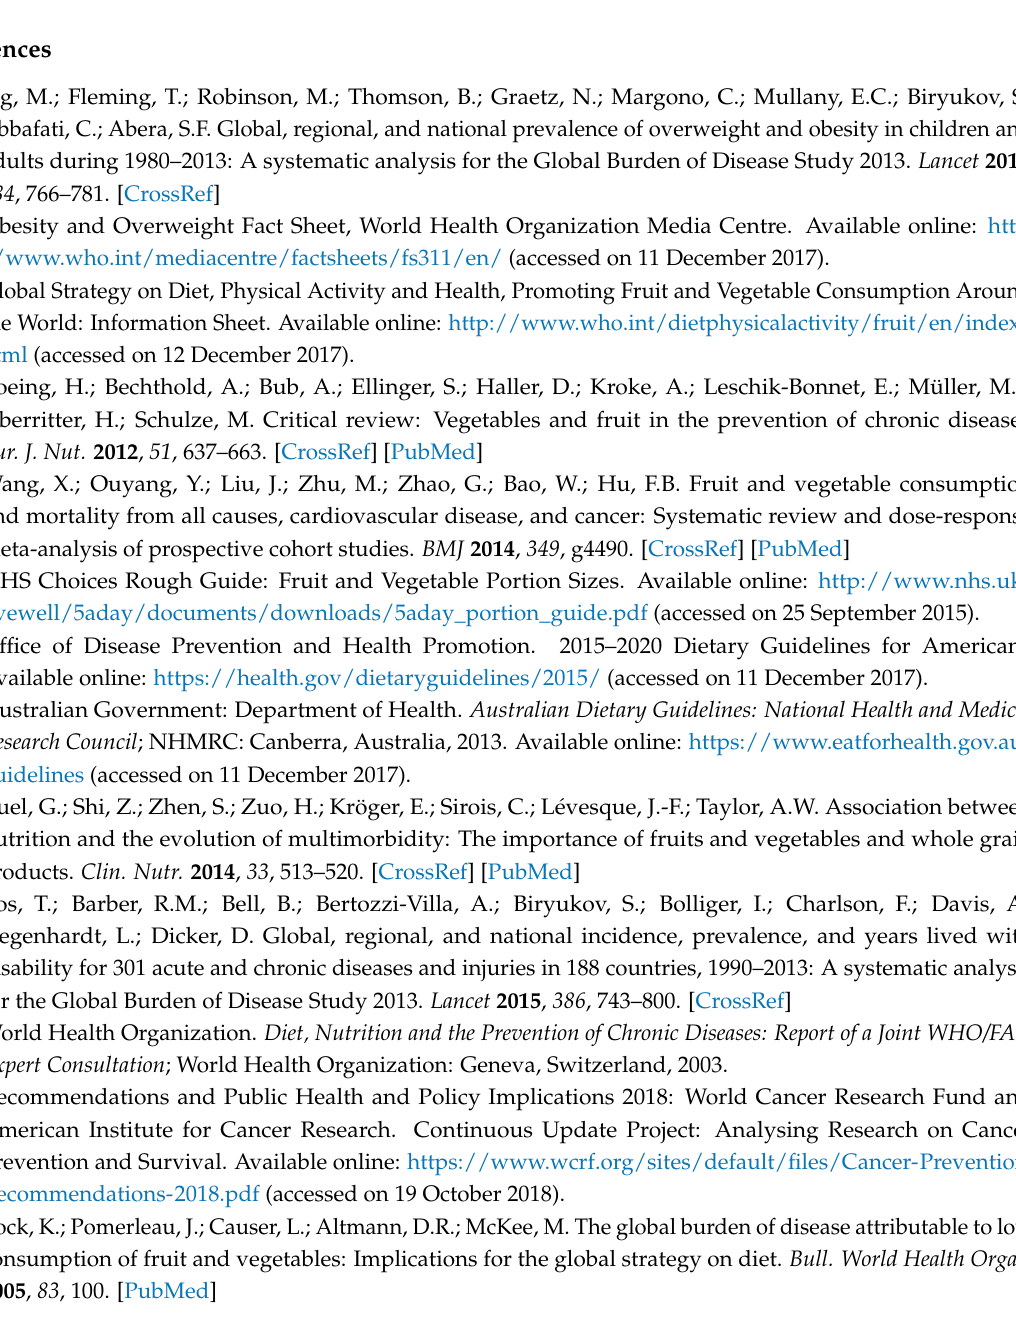
s1, Table S1: Joanna Briggs Institute Critical Appraisal Checklist for Cohort Studies—Outcomes from the two reviewers Figure S1: Forest Plot indicating the effect size calculated from odds ratios or the means and standard error for studies n = 7 included in the review that measured change in vegetable intake over time. Studies which measured intake at baseline only, or were considered poor quality were